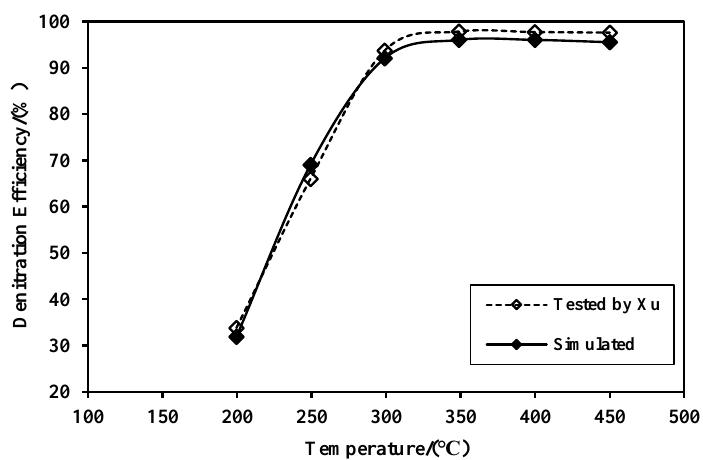
Figure 22. Experimental and simulation results of denitration efficiency at different temperatures.